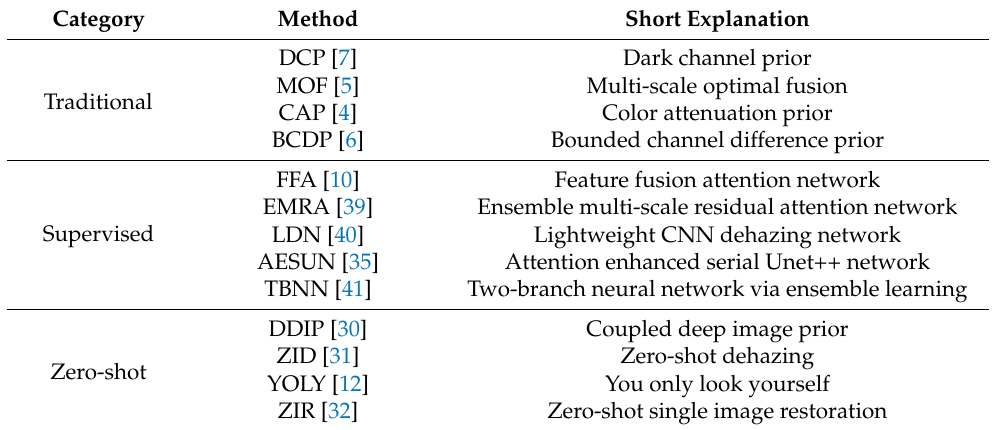
Table 2. Thirteen dehazing methods for comparison are divided into three categories: traditional dehazing methods, supervised-learning-based dehazing methods, and zero-shot dehazing